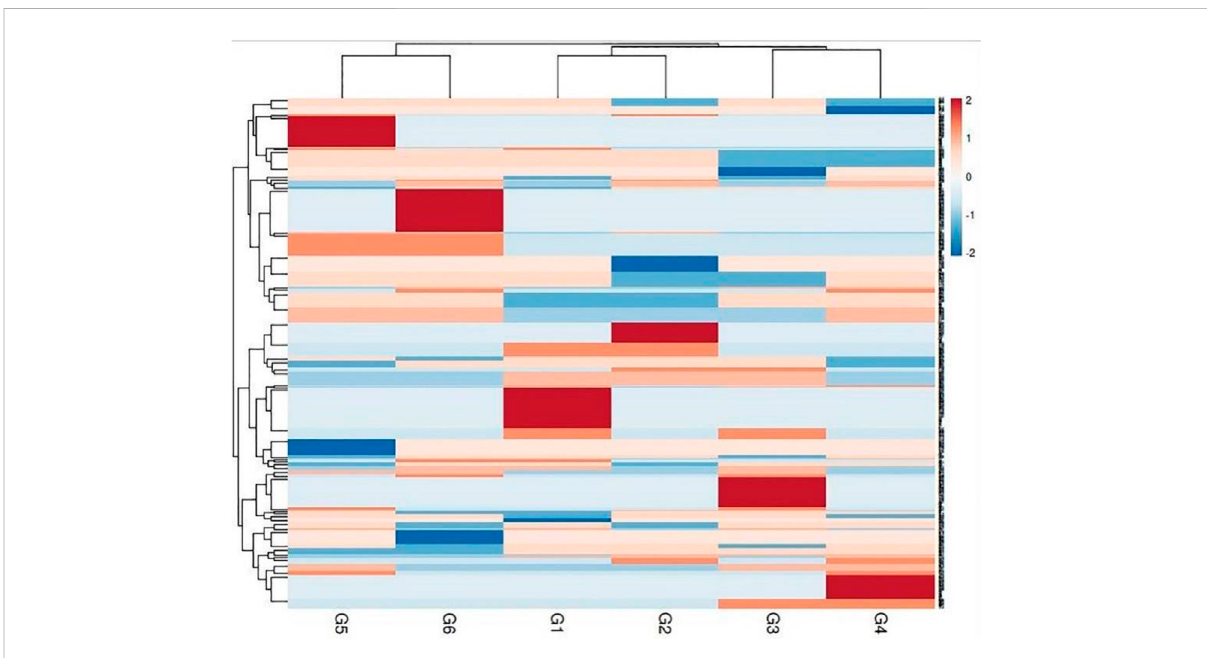
FIGURE 5 Multivariateheatmapillustratingthegeneticdiversityofstudiedsesamecultivars,basedonthe20ISSR,25SCoTprimers,andSDS-PAGEpro fi le using the module of a heatmap of ClustVis — an online tool for clustering and visualizing multivariate data. (1) Ahs-670, (2) As-1236, (3) Bah-697, (4) Jiz-511, (5) Jiz-517 and (6) Bah-312